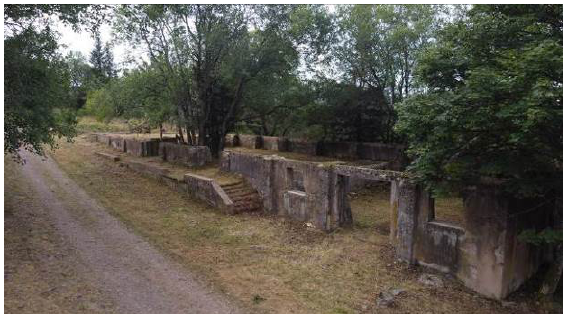
Figure 7 : View of the northeast façade of the depot building (A. Vantillard).